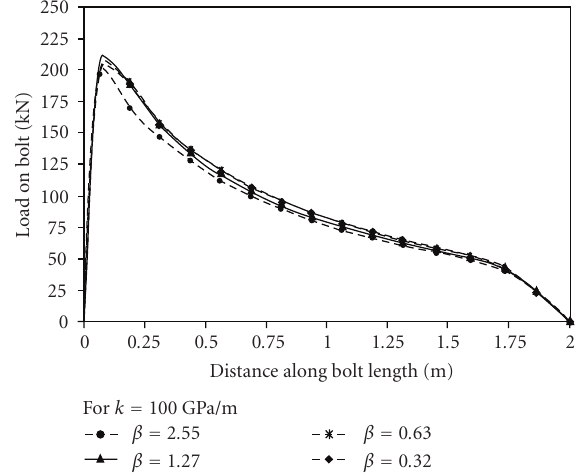
Figure 16: Distributions of radial displacements in rock mass (without faceplate) with bolt density.